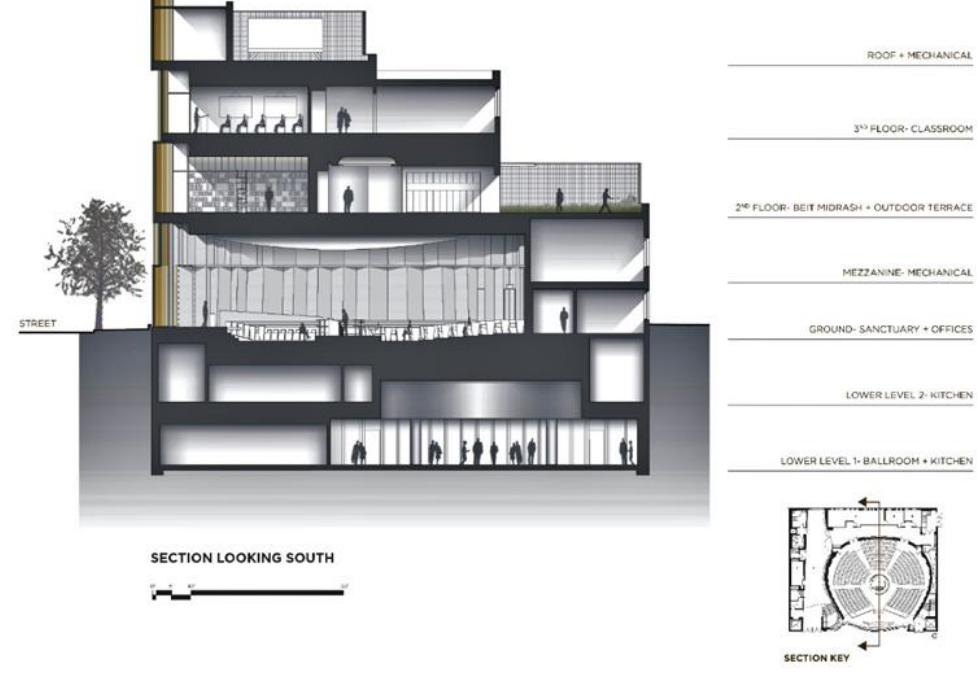
Figure 11. Plan of the ground floor. North is on the right. Courtesy CetraRuddy.